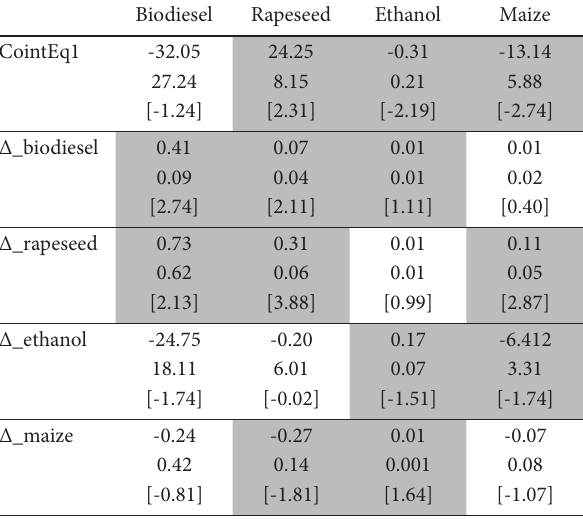
Table 3. The results of the VECM model parameters estimation. Biodiesel Rapeseed